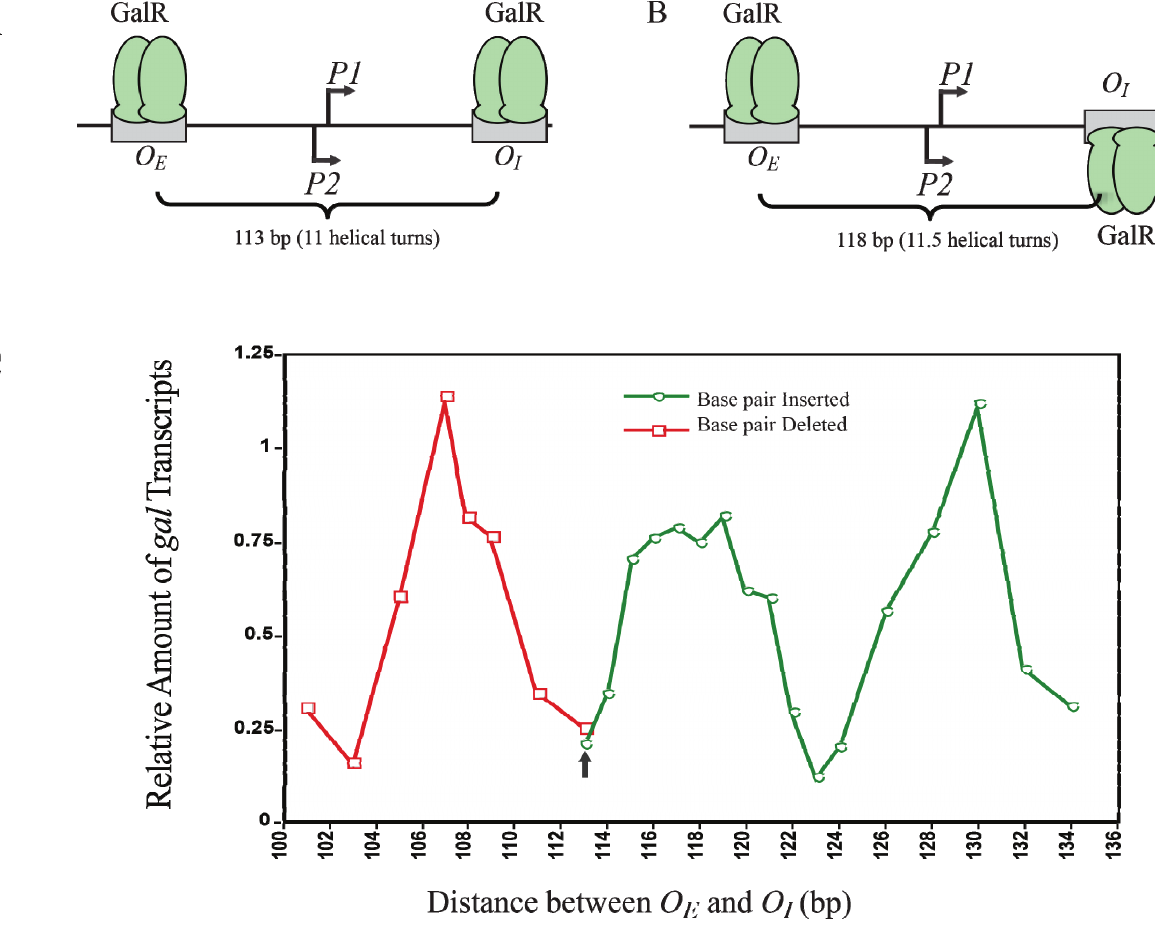
Figure 12. Looping-mediated repression of gal transcription is dependent on the helical distance between operators. ( A ) GalR- O E and GalR- O I are located on the same face of the DNA at a distance of 113-bp (11 helical turns); ( B ) GalR- O E and GalR- O I are located on the opposite face of DNA at a distance of 118-bp; ( C ) Relative amount of transcription vs. distance between the two operators in base pair in the presence of GalR and HU. The results of deleted base pairs (12 bp) are in red and the results of inserted base pairs are in green. The arrow indicates the WT distance between operators (adapted from